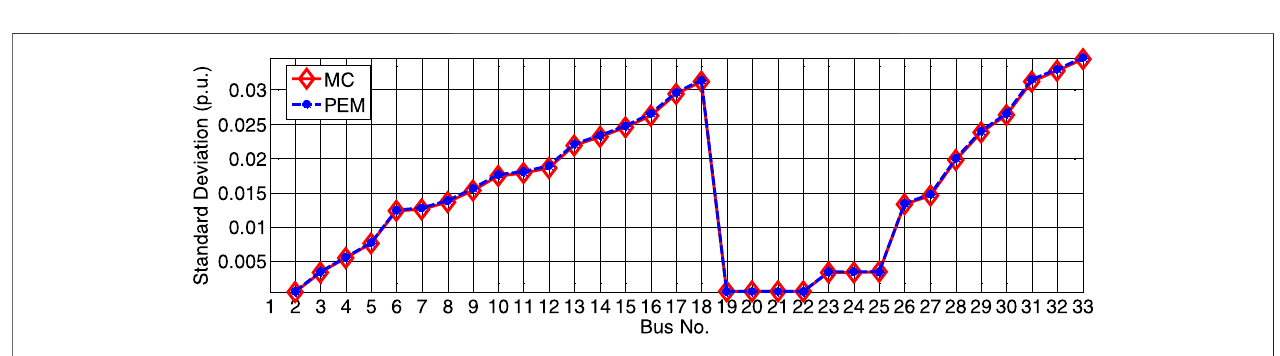
FIGURE 11 | Standard deviation of the elements from bus voltage pro fi les.